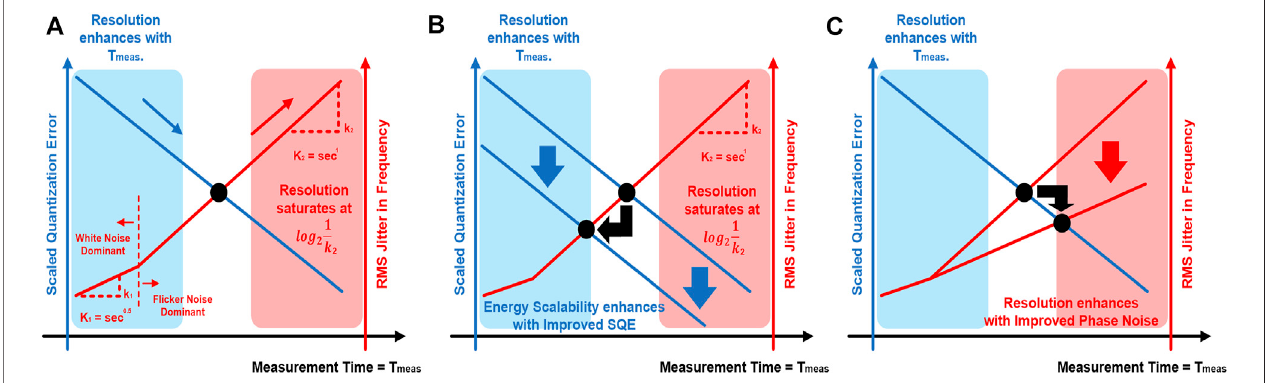
FIGURE2| Operatingprincipleofthetime-basedRDC: (A) resolutiontrade-offsbetweenscaledquantizationnoiseandjitter/phasenoiseoftheringoscillatorinthe design: quantization error decreases with time, whereas jitter accumulates with time, resulting in a saturated maximum achievable resolution in the jitter-dominated region; (B) reduction in measurement time (and hence measurement energyand energy/conversion step) by reducing the scaled quantization error ofthe ring oscillator; (C) improvement in resolution resulting from improving jitter/phase noise of the ring oscillator.